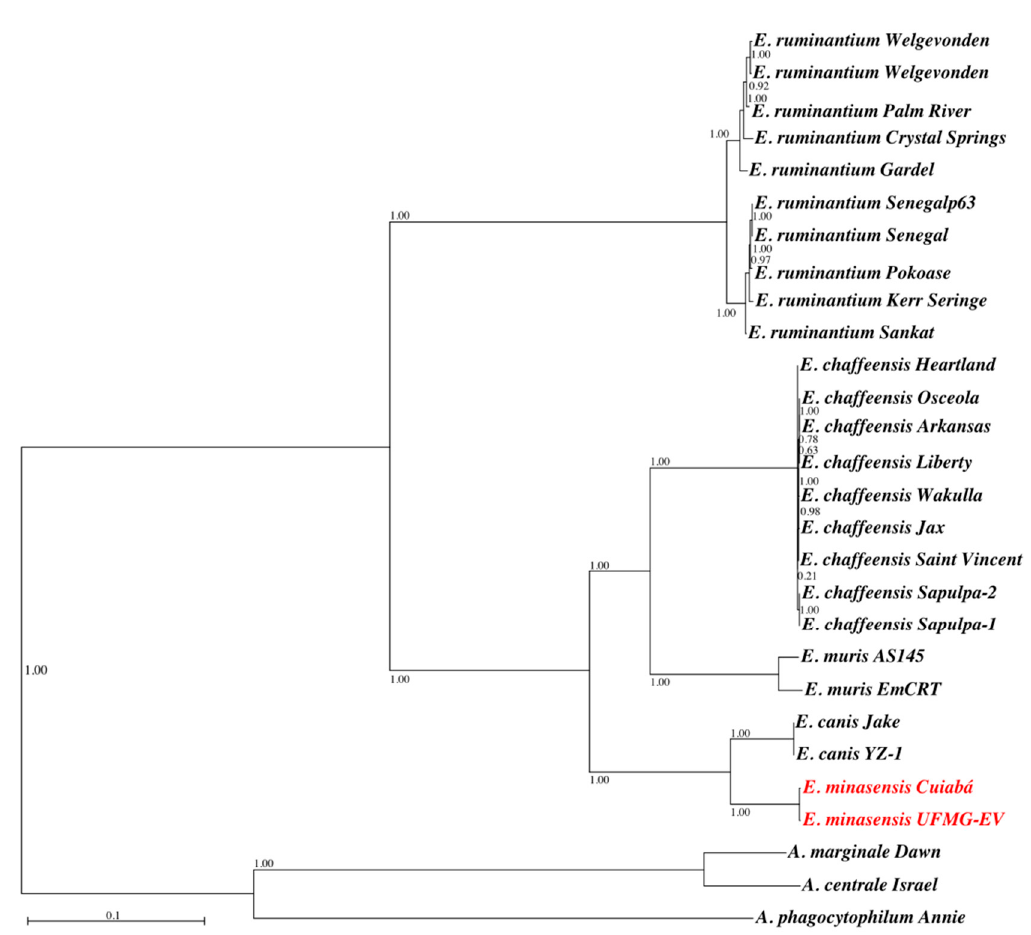
Figure 4. Core-genome-based phylogenetic tree of Ehrlichia . A maximum-likelihood phylogenetic tree was built, using the GTR model and the software PhyML. The final alignment included the nucleotide sequences of 125 protein-coding genes present in the core-genome of the selected bacteria. The genomes of A. marginale , A. centrale , and A. phagocytophilum were included as outgroups. The two strains of E. minasensis are highlighted in red. Values on internal branches represent the statistical support of the topology calculated by